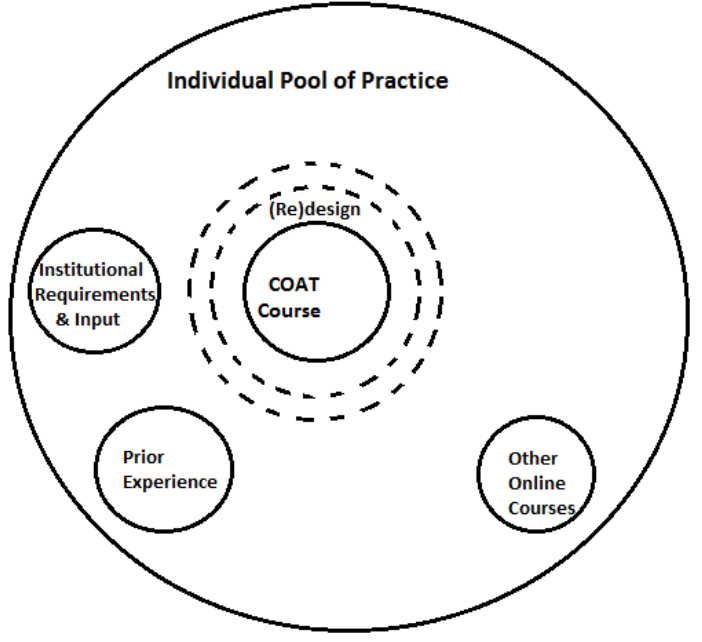
Figure 3. Individual pool of practice.